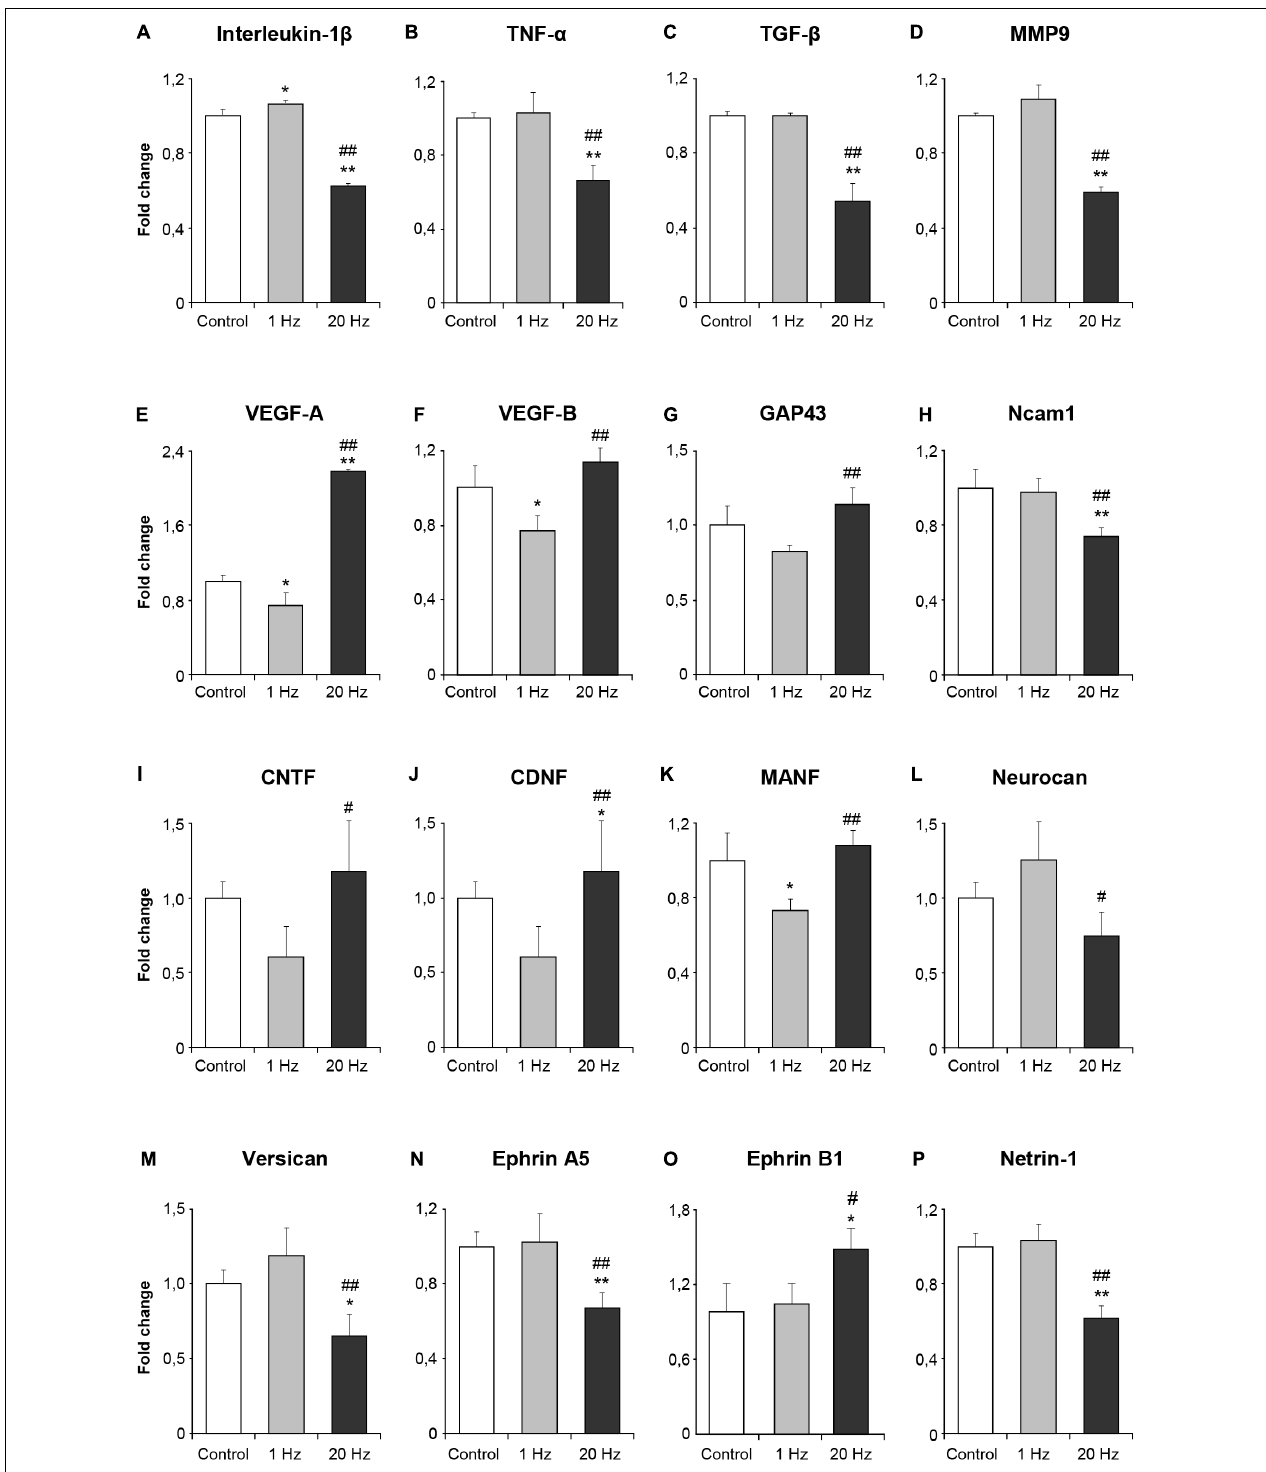
FIGURE 4 | Effect of rTMS on gene expression after cerebral ischemia. Inflammation-related genes after ischemia IL1 β (A) , TNF α (B) and TGF β (C) and MMP9 (D) , angiogenesis-related VEGF-A (E) and VEGF-B (F) , neuroplasticity related GAP43 (G) and Ncam1 (H) , the trophic factors CNTF (I) , CDNF (J) , MANF (K) and Neurocan (L) , growth inhibiting genes Versican (M) , Ephrin A5 (N) and Ephrin B1 (O) , axonal growth related gene Netrin1 (P) . Data were evaluated by one-way ANOVA followed by LSD tests. Data are presented as mean ± SD values ( n = 8–9 mice/group). ∗∗ p < 0.01/ ∗ p < 0.05 compared with control, ## p < 0.01/ # p < 0.05 compared with 1 Hz